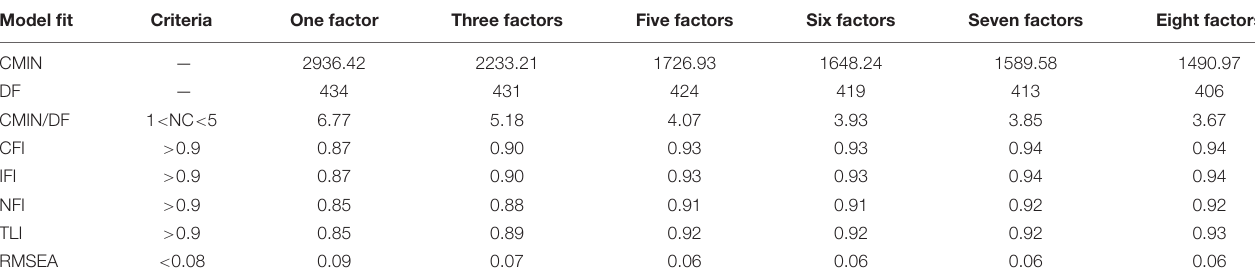
TABLE 3 | The measurement models analysis results.